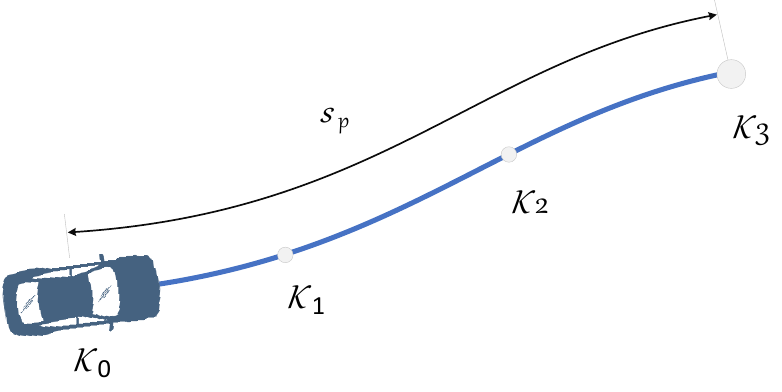
Figure 4. Polynomial